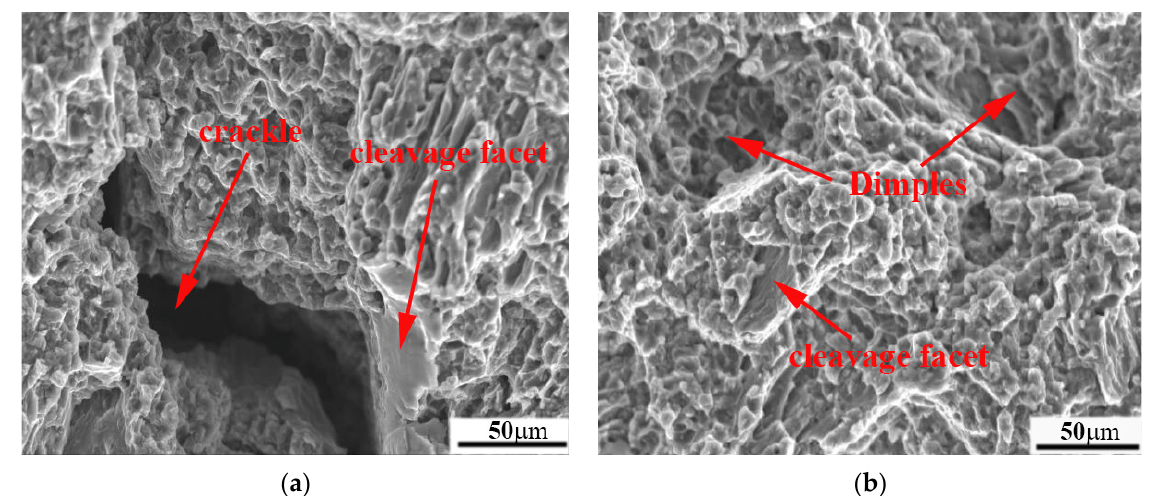
Figure 7. AZ91 magnesium alloy joint tensile fracture morphology. ( a ) Cracking; ( b ) tough fossa and tear ribs.